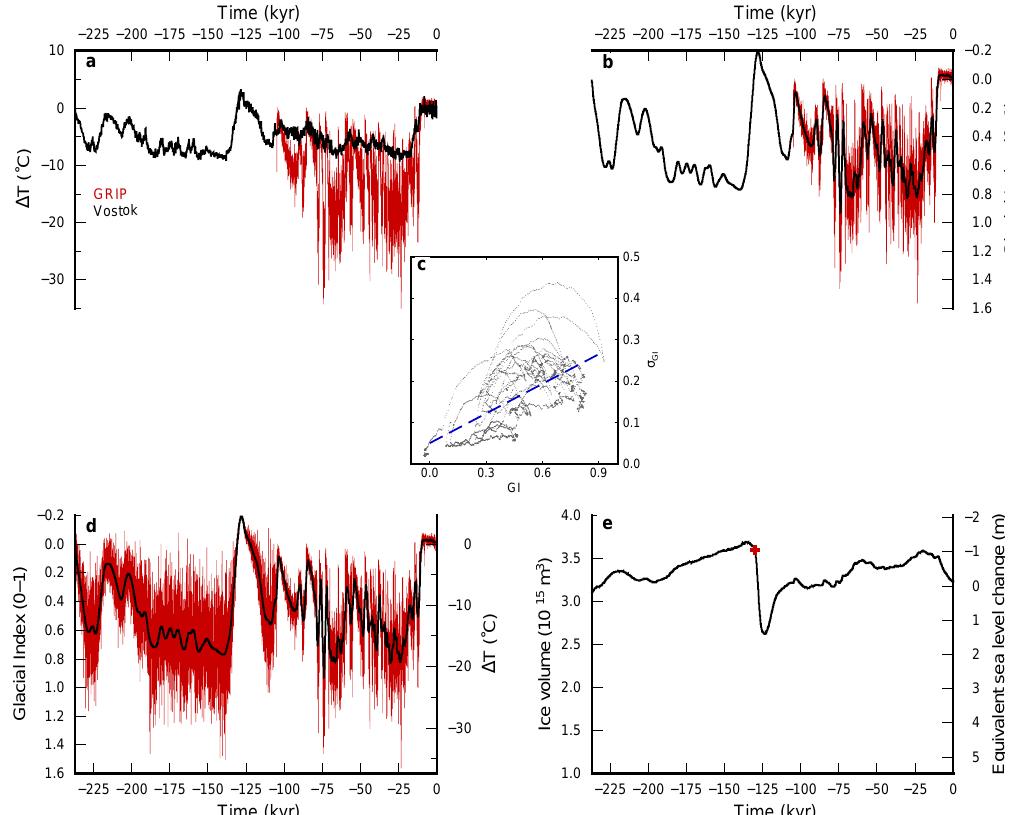
Fig. 4. Climate forcing used to initialise the ice sheet. (a) Near-surface air temperature proxies for the GRIP and Vostok ice cores. (b) Glacial indices derived from these ice core records, with 20yr resolution (red) and after applying a Gaussian filter (black); (c) scatter plot of the standard deviation in the glacial index (GI) within a 3kyr bandwidth filter as a function of the mean GI. (d) Added high-frequency variability of GI in the pre 105kyrBP period. Right axis shows corresponding climate record. (e) Resulting simulated ice volume using the climate forcing from